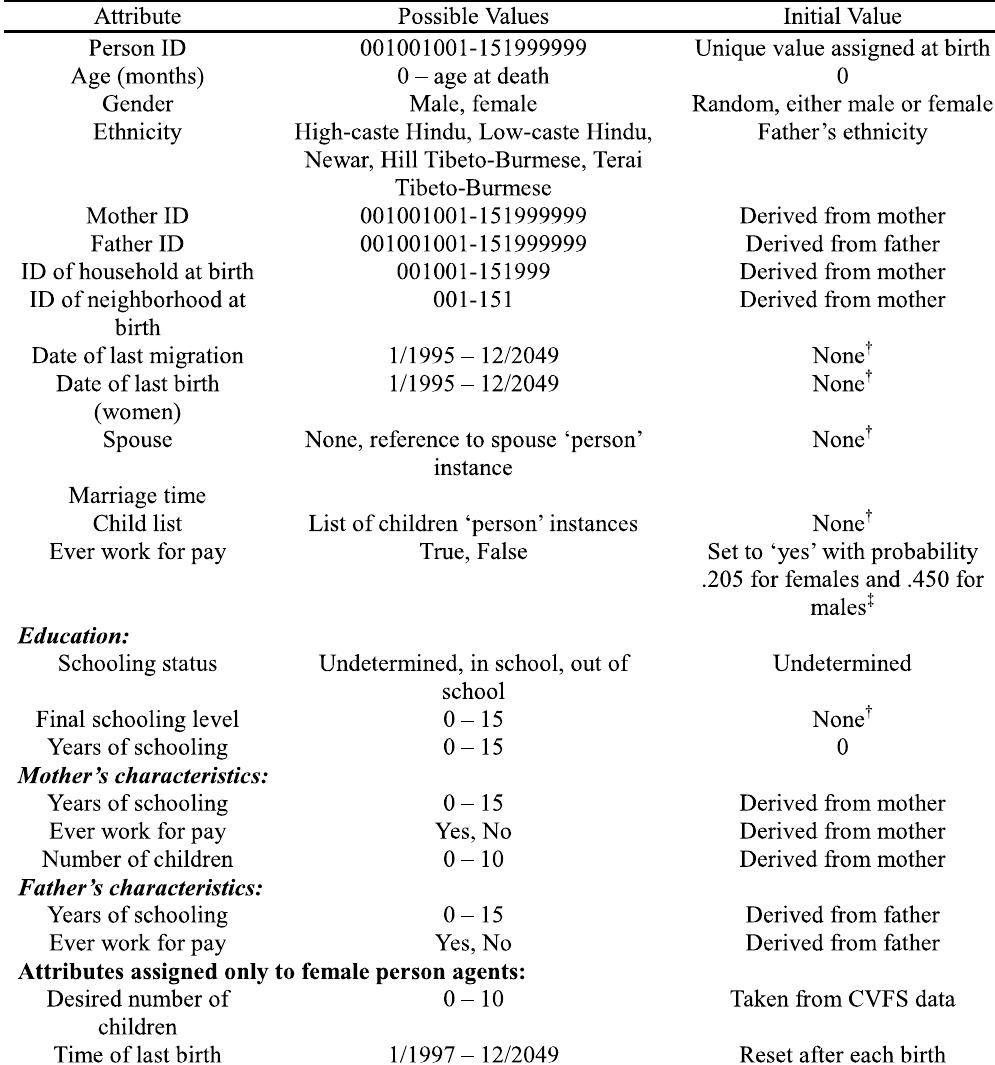
Table A1.1: Attributes of the 'person' agent